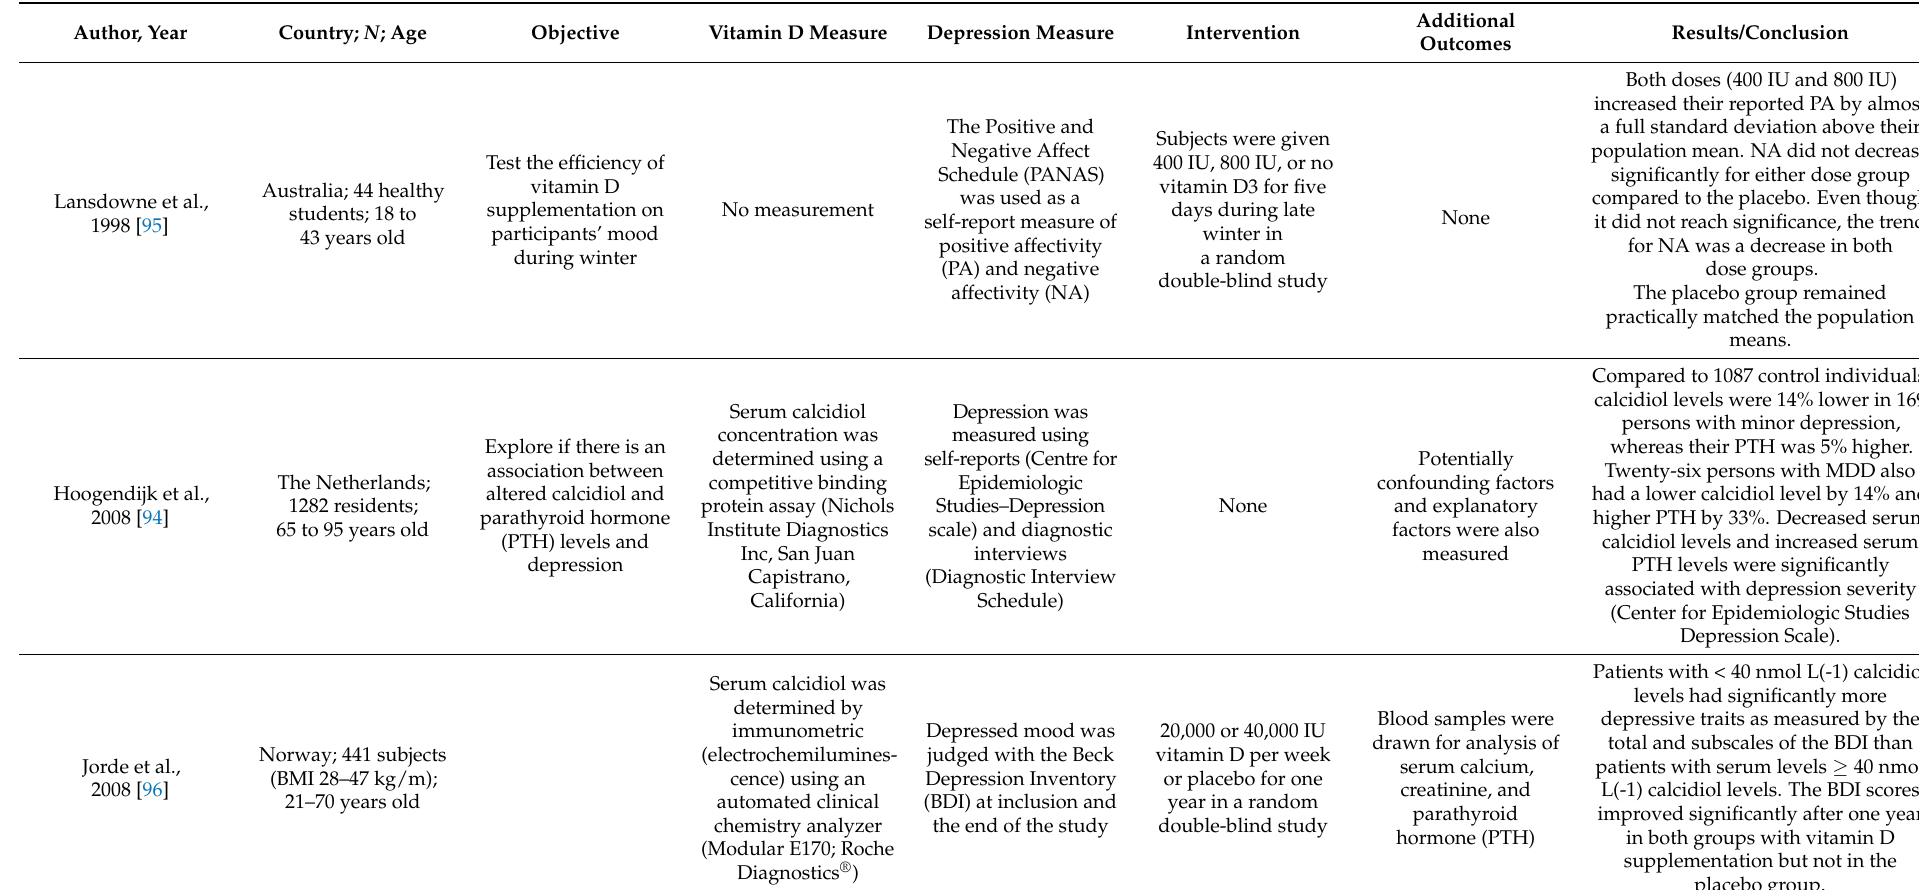
Table 2. Compilation of studies investigating the relationship between vitamin D and